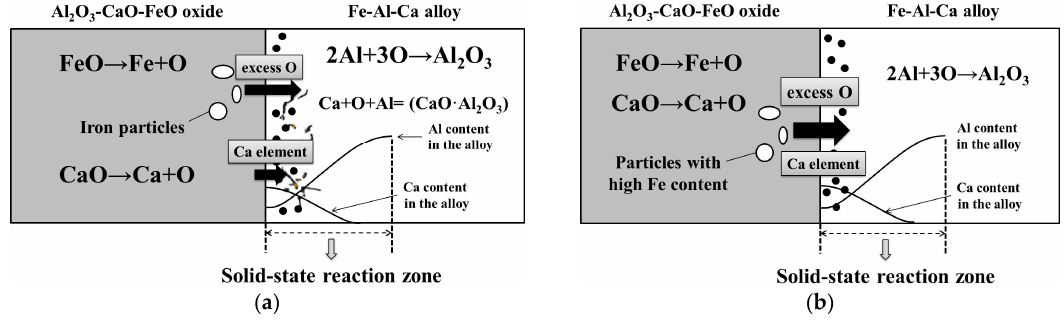
Figure 14. Mechanism of the solid-state reaction at the interface between the Fe–Al–Ca alloy and Al 2 O 3 –CaO–FeO oxide in diffusion couples G0, G1, and G2: ( a ) G0 and G1; ( b ) G2.